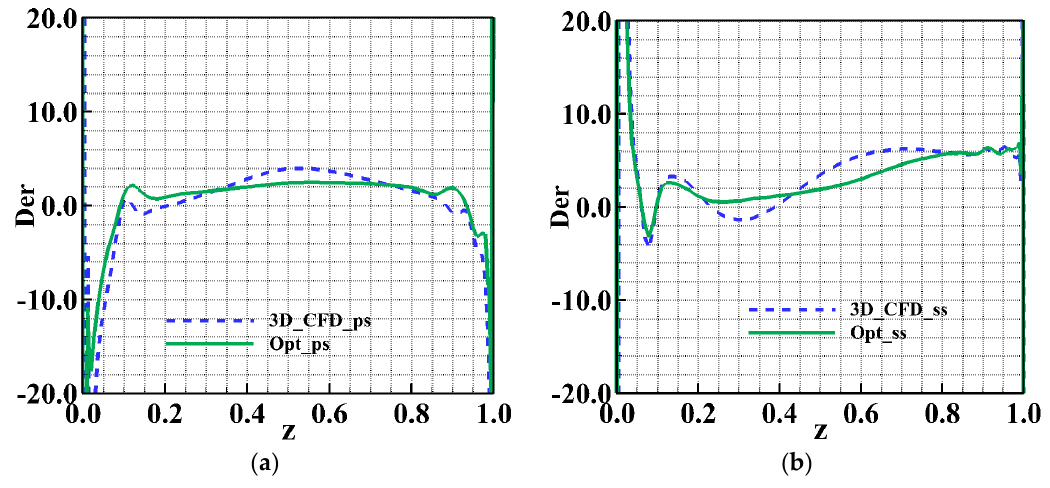
Figure 15. The first derivative of static pressure at the 0.5% span section of rotor1. ( a ) The pressure surface; ( b ) The suction surface.